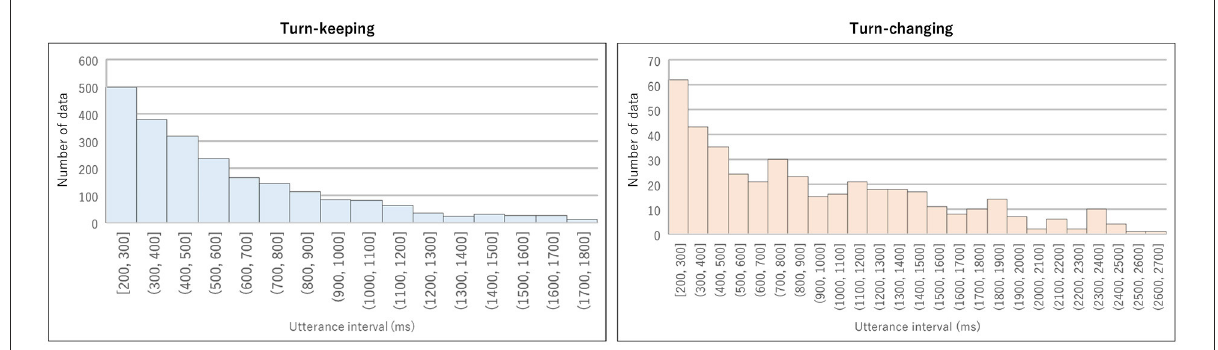
FIGURE2 Histogram of utterance interval duration for turn-keeping (left) and turn-changing (right) from MM-TMW